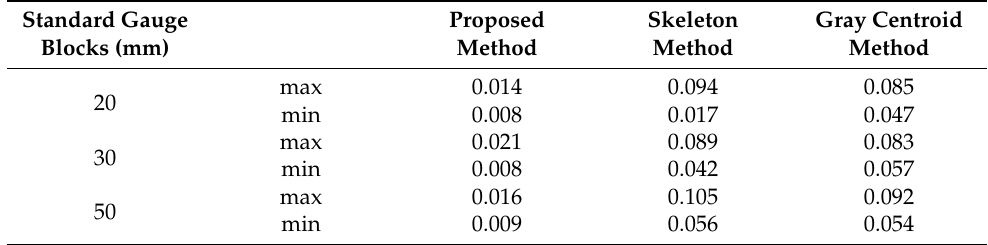
Table 2. The average deviation of different methods comparing the standard value (unit: pixel).